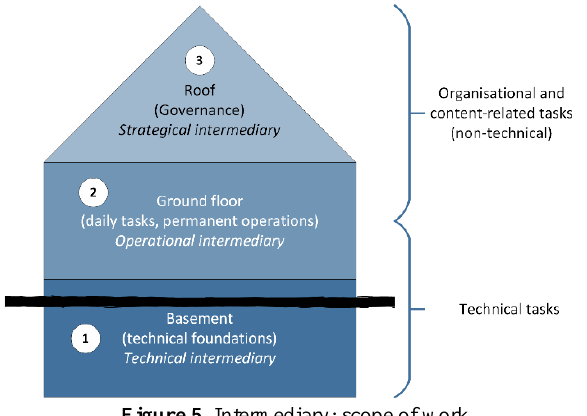
Figure 5 . Intermediary: scope of